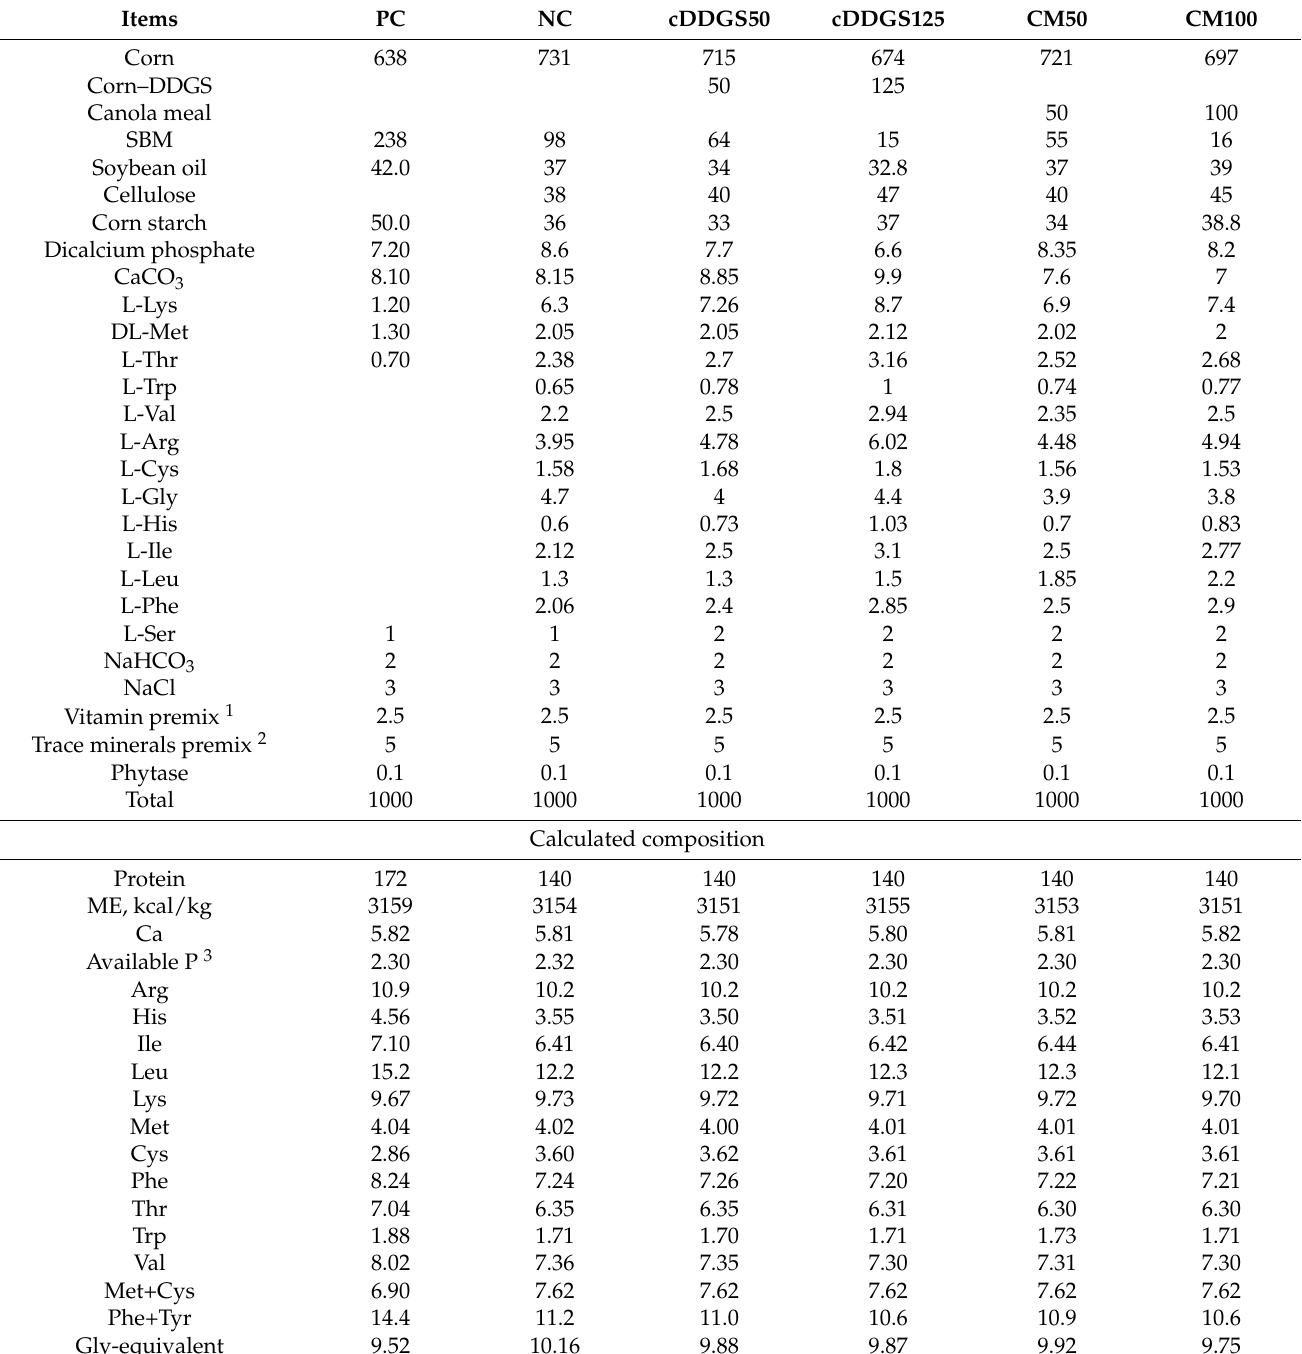
Table 4. Feedstuffs and chemical compositions (g/kg) of finisher phase diets (d 28 to 42) fed to broilers receiving diets containing soybean with reduction in crude protein or low-protein diets with serial inclusion levels of canola meal or corn–DDGS supplemented with crystalline amino